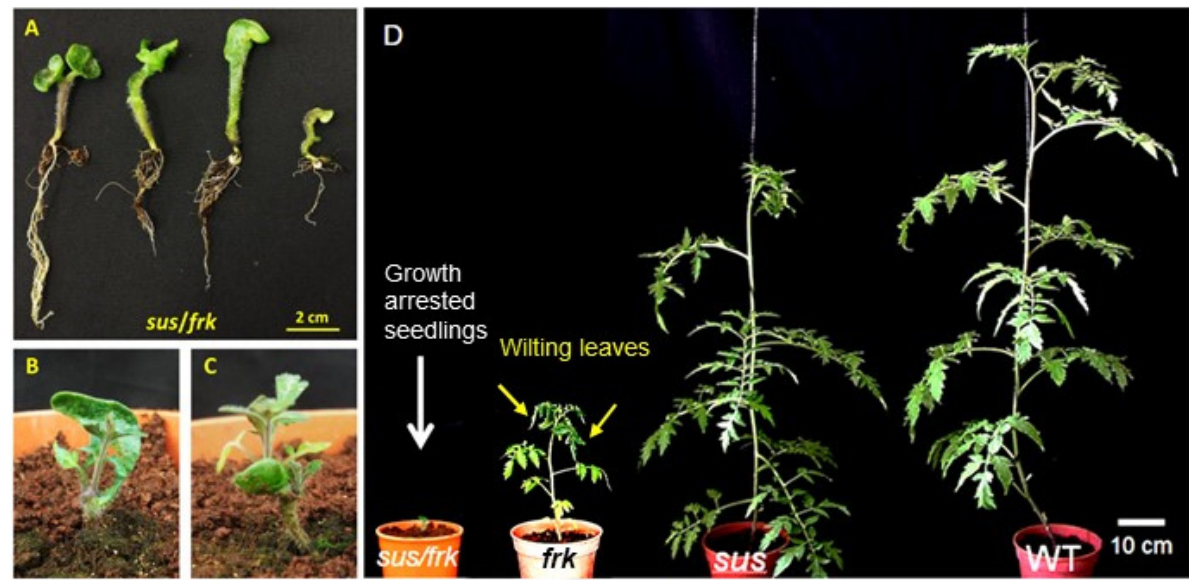
Figure 1. Phenotypes of F1 seedlings from the cross between the sus and frk plants. ( A ) Four of the F1 seedlings from the cross between the sus and frk plants at 8 weeks after germination. The seedlings did not show any visible shoot growth but did seem to have sufficient root systems. ( B , C ) Two seedlings from the same cross developed visible shoots, but remained abnormally short. ( D ) Six-week-old sus / frk growth-arrested seedling and frk , sus, and WT plants.